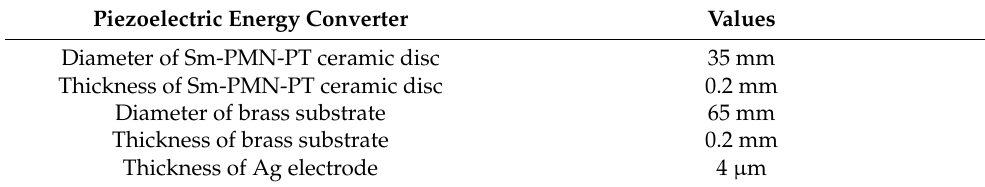
Table 2. Summary of components of the buzzer-type piezoelectric energy